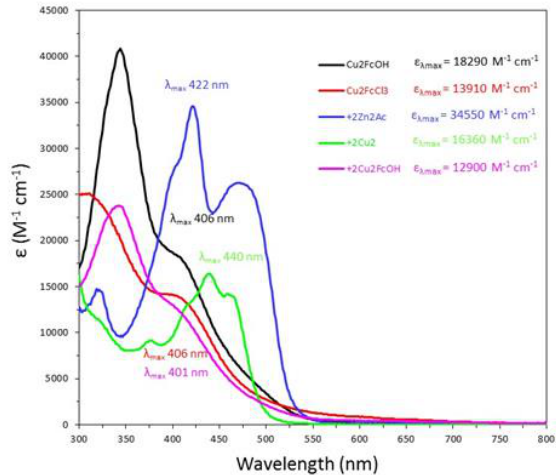
Figure 3. UV-Vis absorption spectra of all molecular spacers. Molar extinction coefficients were calculated from known concentration solutions and absorbance measured at the charge transfer bands labeled by the λ max .